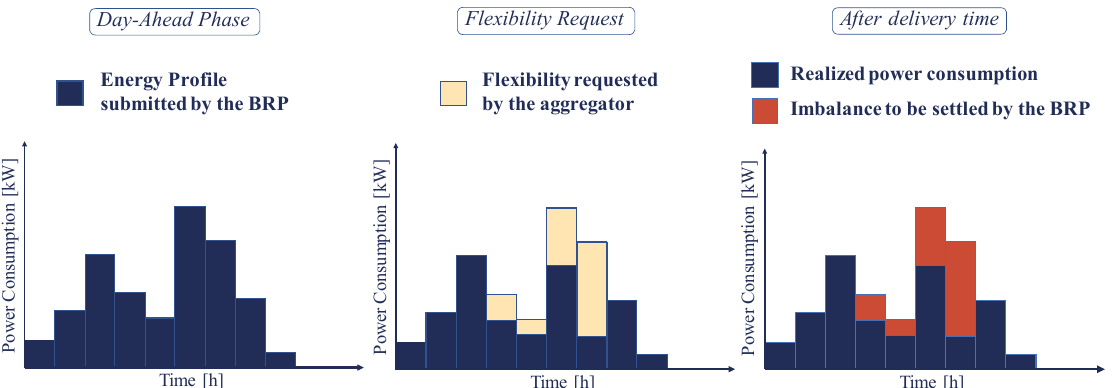
Figure 4. Impact of flexibility activation by an independent aggregator on the Balance Responsible Party’s (BRP’s) energy